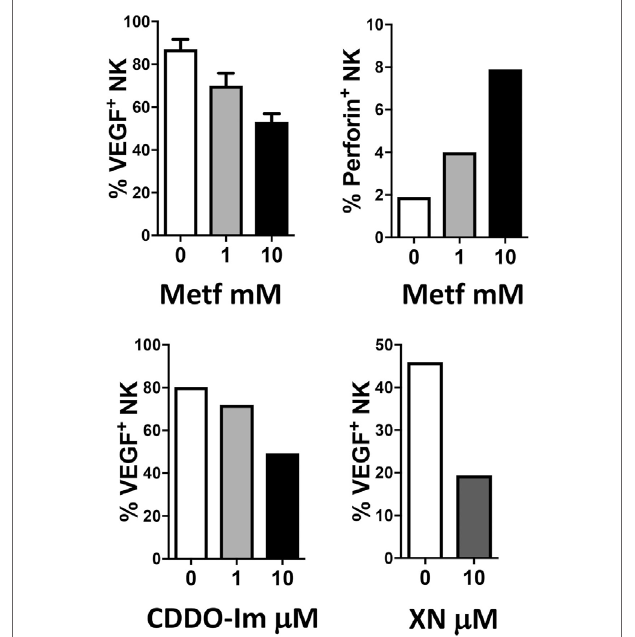
FigURe 5 | Examples of effects of repurposed drugs and phytochemicals on natural killer (NK) cell repolarization. The biguanide metformin (Metf), the synthetic triterpenoid 1[2-Cyano-3,12-dioxooleana-1,9(11)-dien-28-oyl] imidazole (CDDO-Im) and the hop flavonoid xanthohumol (XN) can decrease vascular endothelial growth factor (VEGF) production in non-small cell lung cancer associated NK cells and at the same time can upregulate perforin production. Graphs show data obtained from multicolor flow cytometry analysis of total NK cells (CD45 + CD14 − CD3 − CD56 + cells) from peripheral